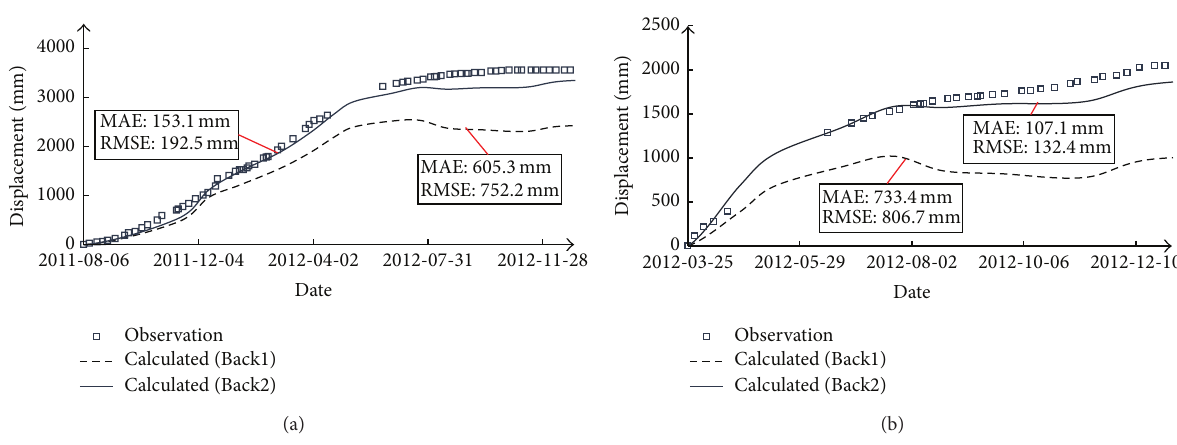
Figure 10: Comparison of calculation results based on the two sets of back-calculated parameters through construction completion.